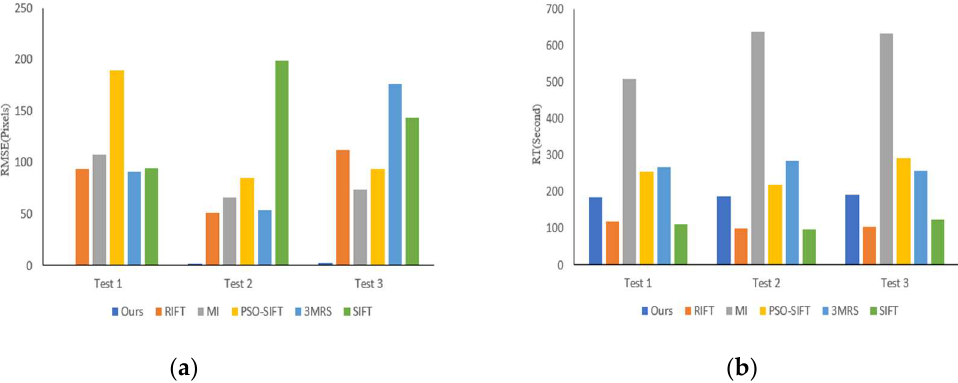
Figure 12. Matching performance comparison of different methods in two criteria for experimental images. ( a ) the histograms of RMSE for all experimental methods, ( b ) the histograms of RT for all experimental methods. Table 8. Registration results of the proposed method, RIFT, MI, PSO-SIFT, 3MRS and SIFT.